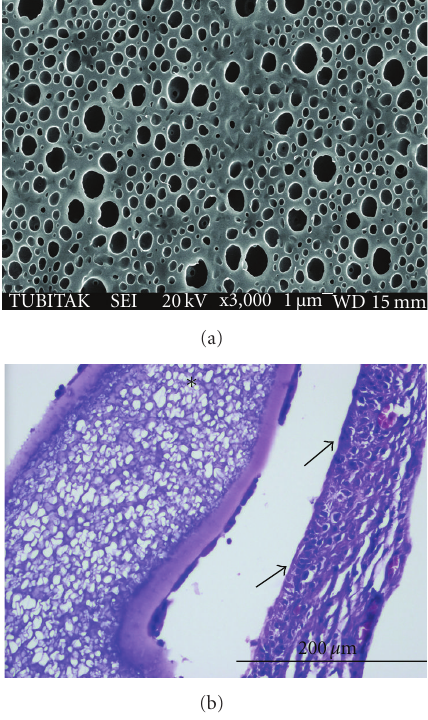
Figure 5: (a) SEM analysis of Au-PP-PEG-4000 on 30th day (3000x magnification) and (b) histological section of Au-PP-PEG-4000 on 30th day of implantation (H&E, 20x magnification). Multiple punched holes are seen in both SEM section and histological